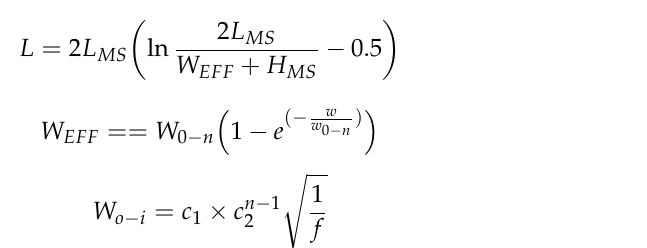
Figure 2. ( a ) Traditional plate capacitor e-field lines and ( b ) IDC structure capacitor e-field lines. Similarly, the inductor is another parameter that also affects the resonating frequency of the proposed microwave sensor. The dual wide gap slit on both sides of the IDC structure is connected with spiral inductance, and the rings are added to enhance the confinement of the e-field. The total inductance produced by the designed sensor is a combination of mutual and self-inductance and can be represented as [31]: